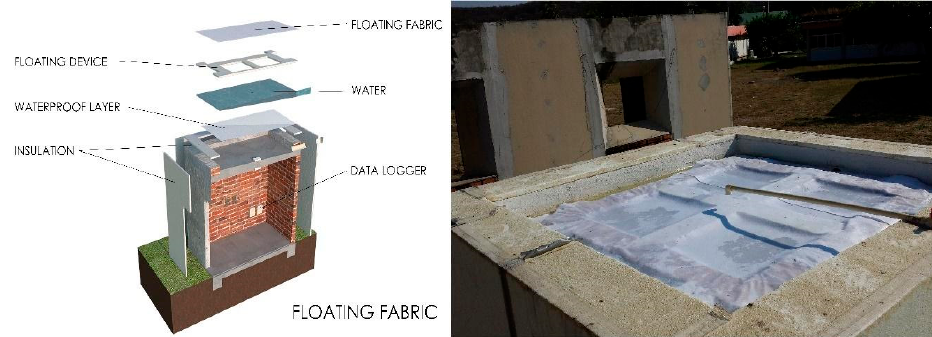
Figure 7. Cross section diagram of the floating fiber or gunny bag cell with its elements.